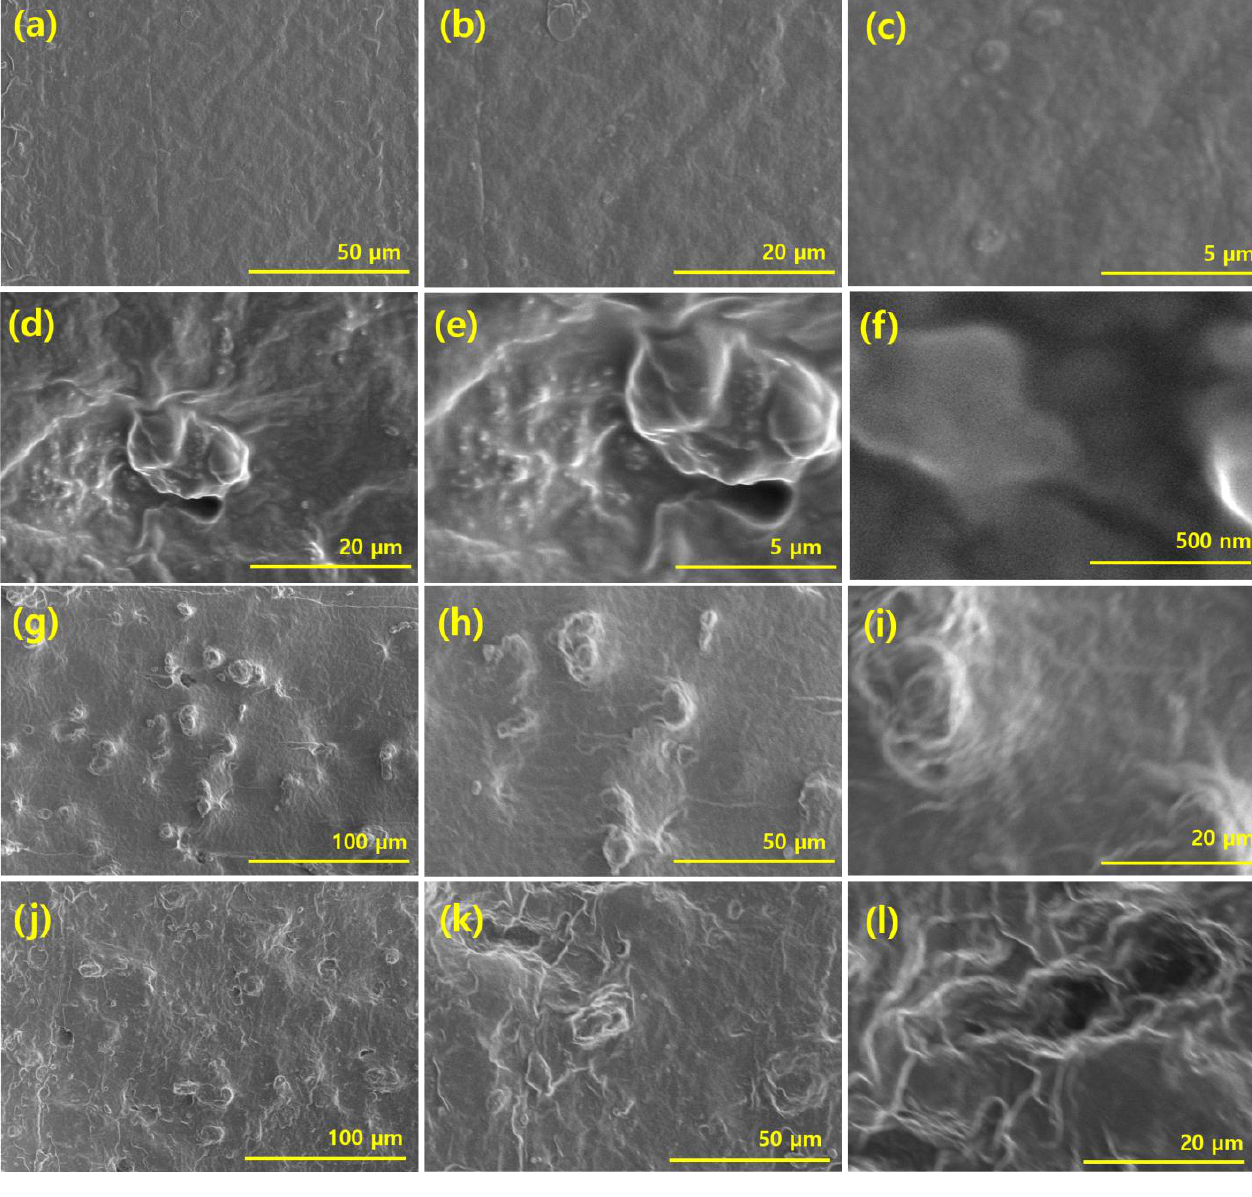
Figure 2. SEM of composites: ( a – c ) control; ( d – f ) 10 phr of GNPs ( g – i ) and 60 phr of EIP; ( j – l ) 60 phr of hybrid.